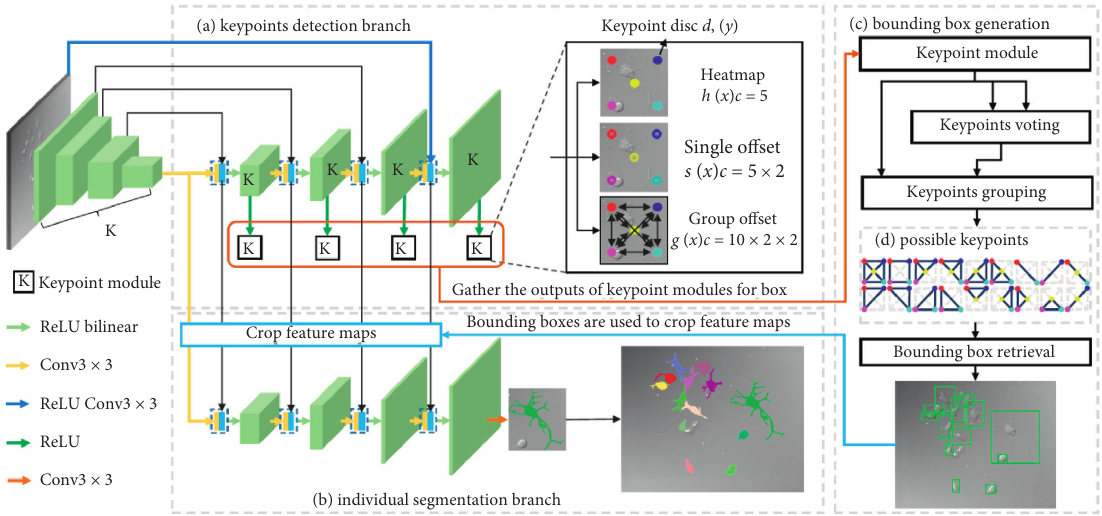
Figure 3: Schematic diagram of the overall